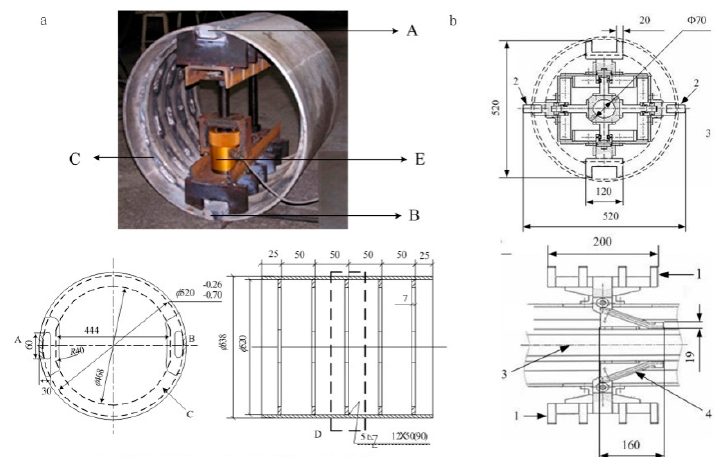
Figure 1. The welding structure and finite element (FE) model. ( a ) Welding structure: first, the stiffeners (C) were welded onto the cylinder substructures (D) by 24 separate fillet welds; the welding fixtures (E) were installed on the whole structure to make sure it would not collapse; then, parts A and B were removed by machining; finally, the five cylinder substructures were welded together by four butt welds. ( b ) Welding fixture, 1-Vertical supporting claws; 2-Horizontal supporting claws; 3-Central spindle; 4-Linkage and rolling wheel.